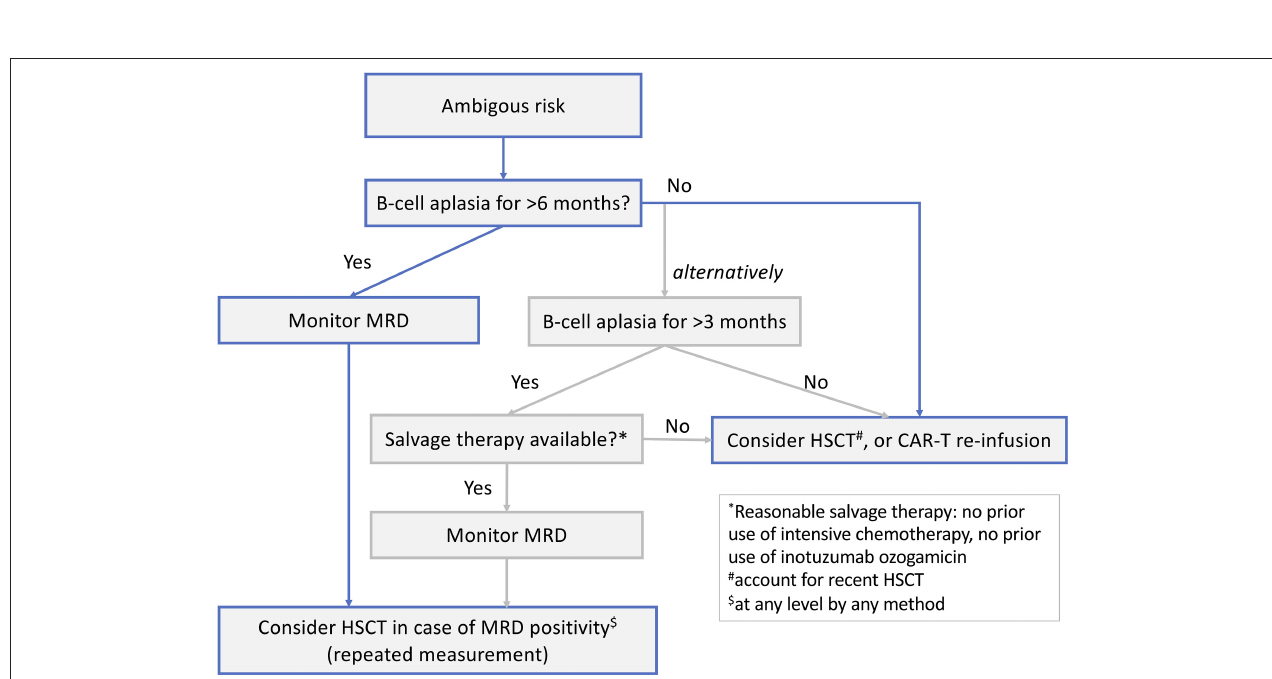
FIGURE 6 | Follow-up guidance after CAR-T for paediatric patients and AYA with BCP-ALL and an “ambiguous risk profile” (see Figure 5 for criteria for an ambiguous risk profile).